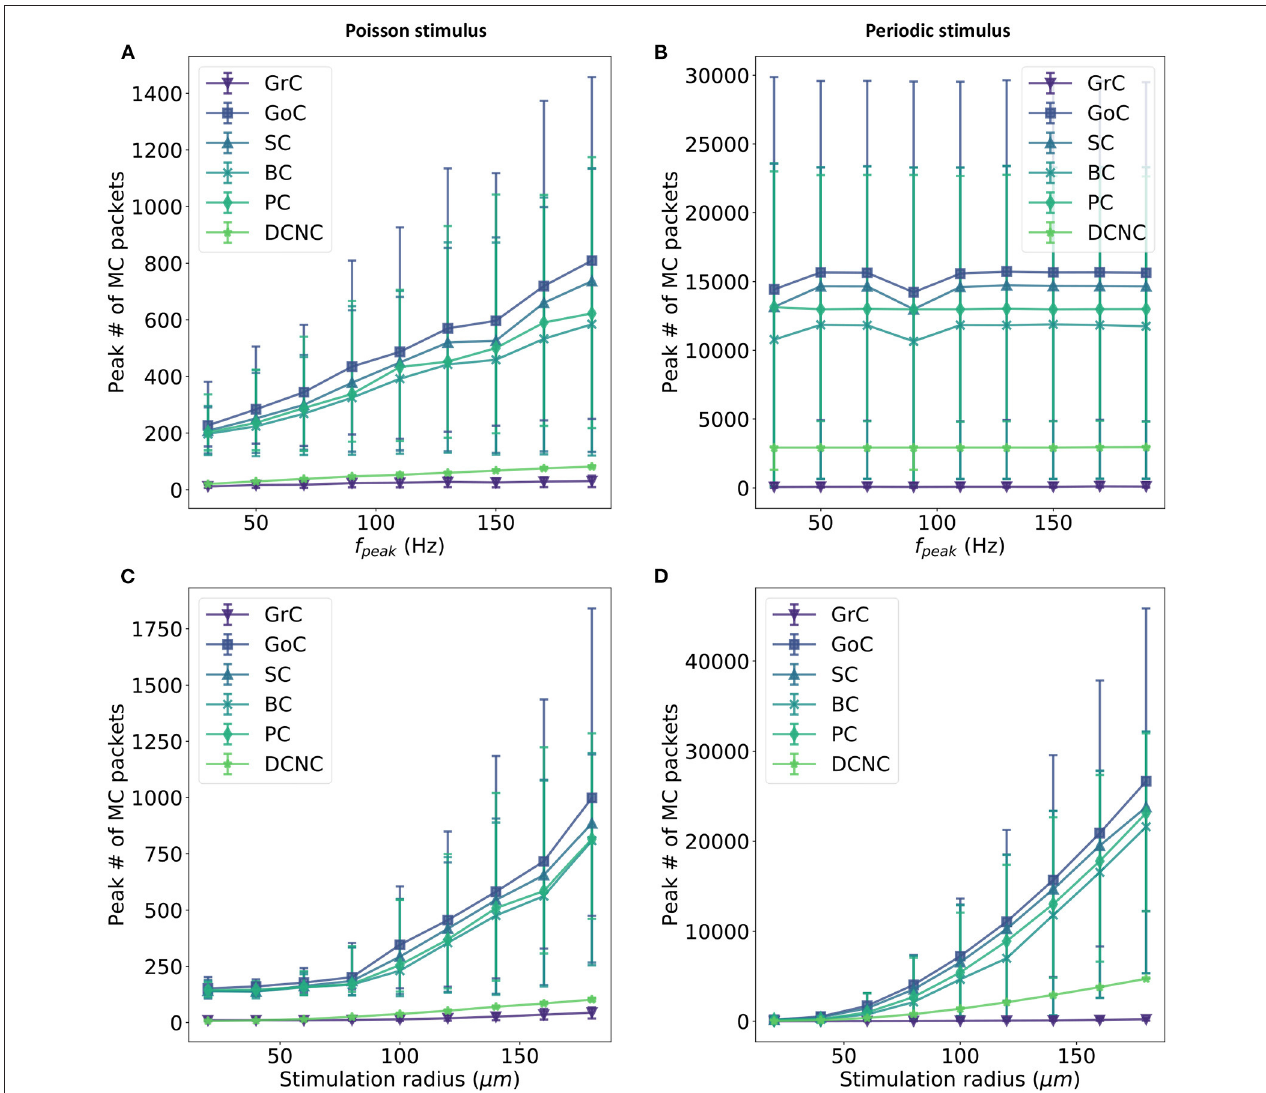
FIGURE 6 | Relationship between input firing rate and maximum number of packets received by each core in a timestep. Input activity is controlled in two ways: a fixed set of Glomeruli is activated at a variety of firing rates ( f peak )— (A,B) —or a variable set of glomeruli (controlled by the size of the stimulus selection radius) is activated at a fixed rate (C,D) . Two input stimulus encodings are used: Poisson input (left) and periodic input (right). The first row compares the maximum number of spikes received in a timestep for all other population in the model when varying the input firing for a fixed subset of Gloms, while the second row compares the